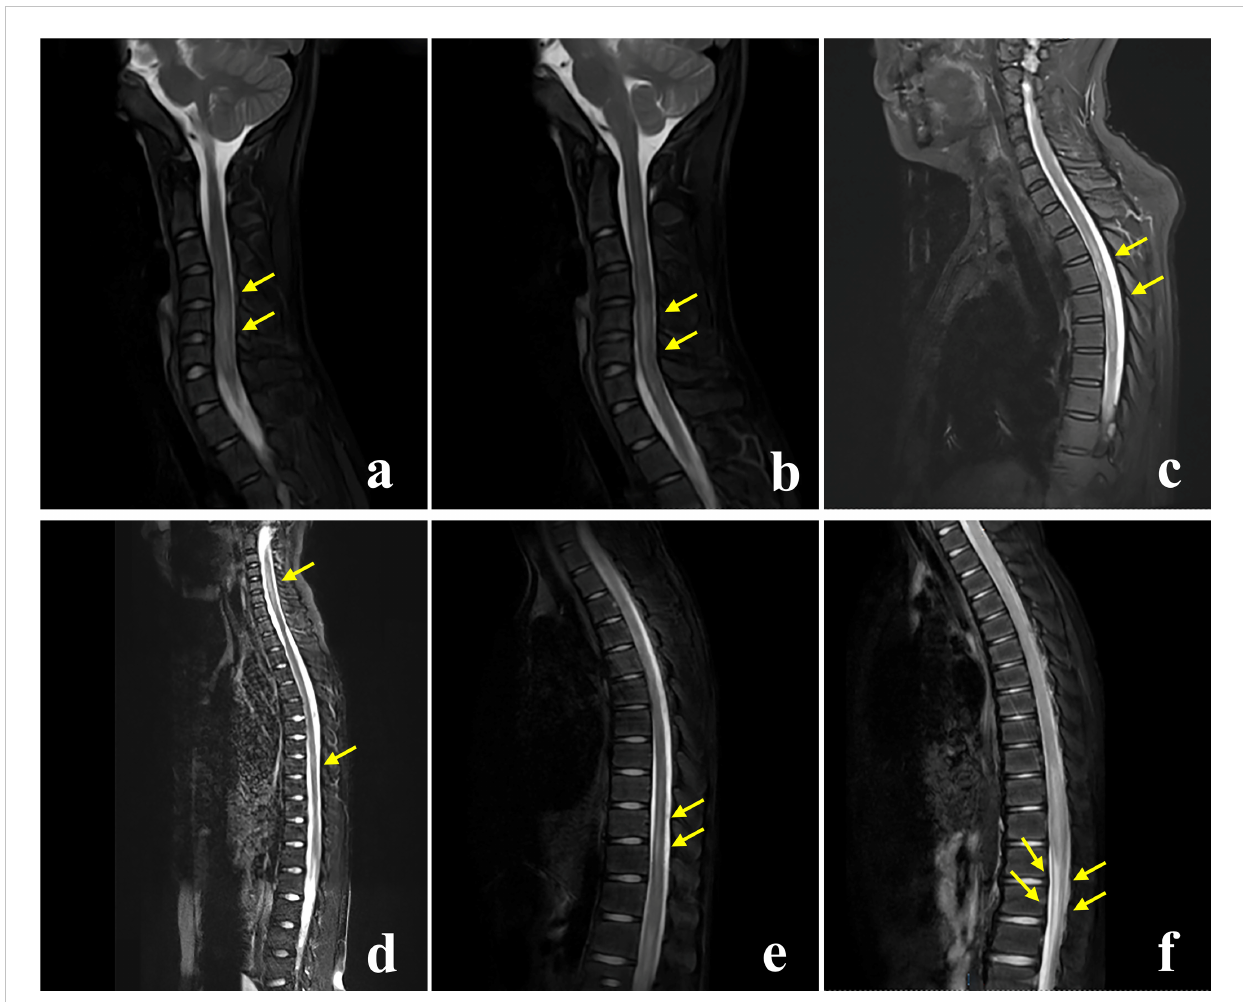
FIGURE 4 Spinal cord MRI characteristics of patients with Anti-GFAP antibodies. The MRI T2-weighted fat suppression sequence of the spinal cord in patients with anti-GFAP antibodies shows that the morphology of spinal cord lesions could be long-segment patchy lesions (A, B) , multiple short-segment lesions (C) , and long-segment linear lesions (D, E) . Abnormal signal of conus medullaris in 1 patient (F)